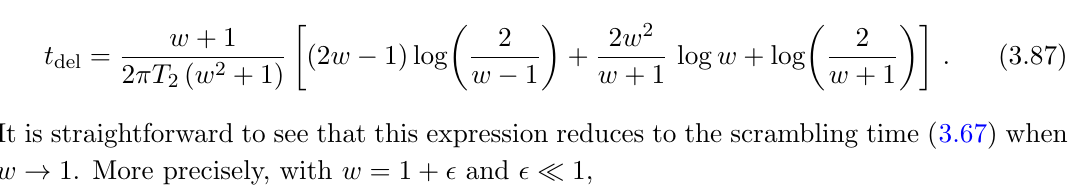
Figure 9. The ‘delay’ time (3.87) as a function of the energy in the shock wave. For w have a line of slope {1, which is characteristic of the scrambling time in eq. (3.67), as expected from eq. (3.88). For heavy shock waves, t del approaches a constant proportional to 1 =T 2 , as shown in eq.